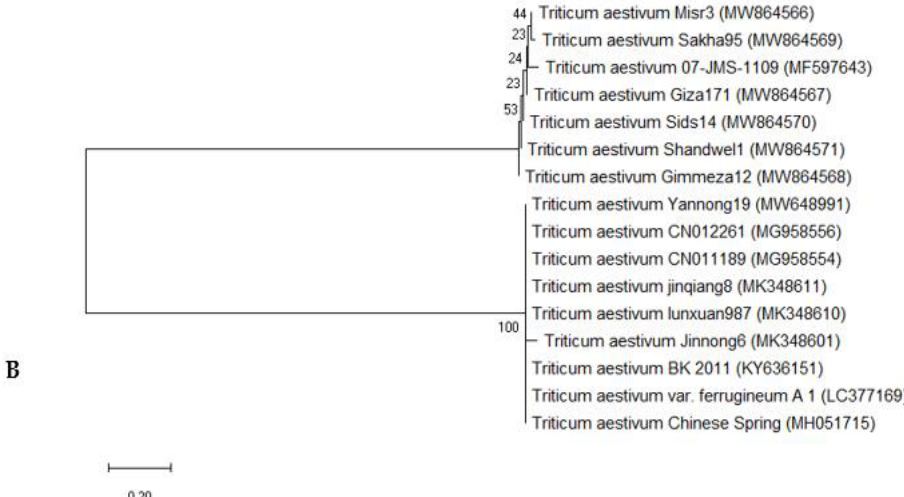
Figure 8. Maximum likelihood tree analysis UPGMA of 6 selected T. aestivum genotypes: W16 (MISR 3), W3 (SIDS 14), W7 (GIZA 171), W4 (SHANDWEEL1), W13 (GEMMIZA 12) and W6 (SAKHA 95) and 10 NCBI outgroups, using MEGAX software based on ( A ) rbcL sequence data of and ( B ) matK sequence data. Numbers indicated on the similarity percentage and the organism accession numbers represented in parentheses.